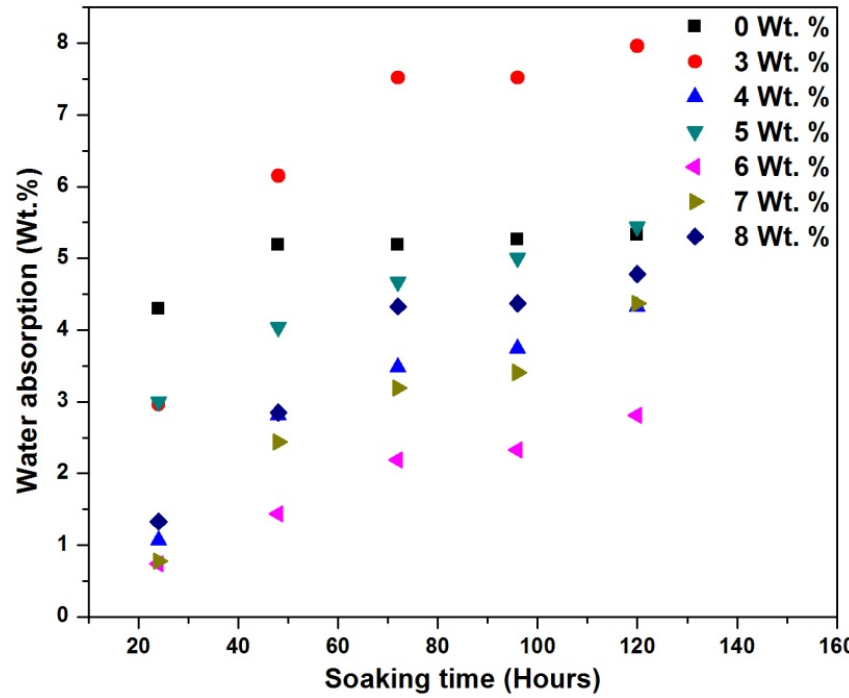
Figure 10. Water absorption of treated CCP-PLA nanofibre at 22